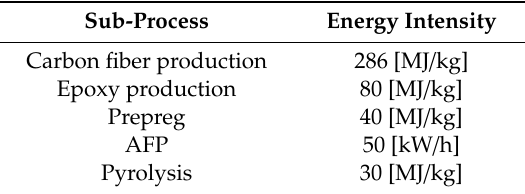
Table 9. Energy intensity of each